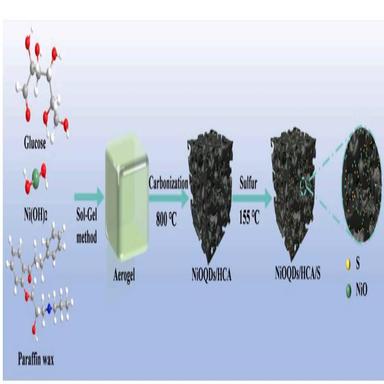
Schematic illustration of the fabrication of the NiOQDs/HCA/S.